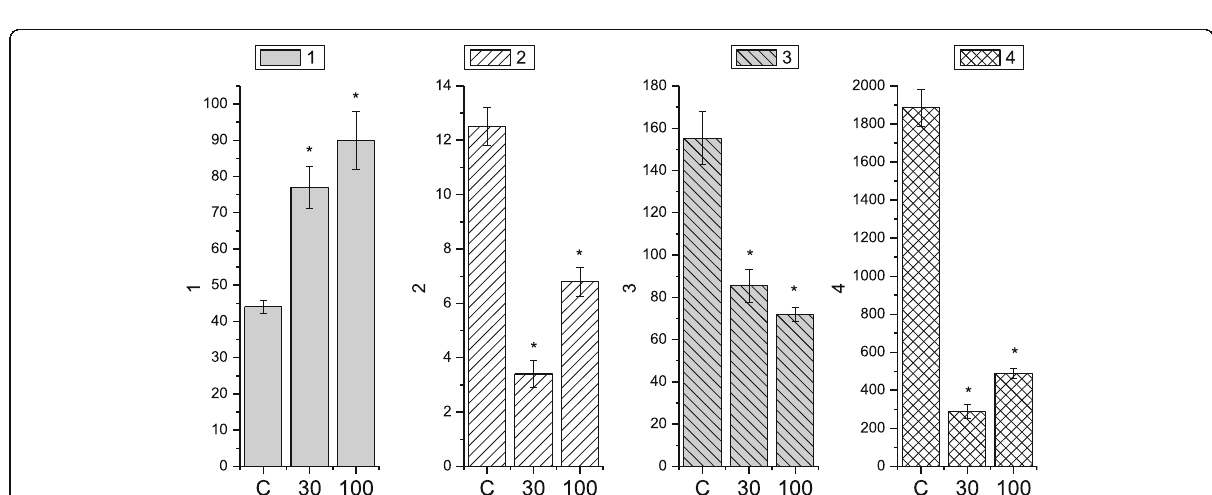
Fig. 3 Histograms of the kinetic analysis parameters for spontaneous contractive activity of circular smooth muscles of the caecum ( C , control; 30 and 100, term (days) of burdening the rats with the suspension of nanosize titanium dioxide material): (1) frequency of preparation contractions for 10 min; (2) averaged value of the duration of contraction – relaxation cycle (sec); (3) MU index of contractions; and (4) AU index of contractions. * p < 0.05, reliability of changes compared to the